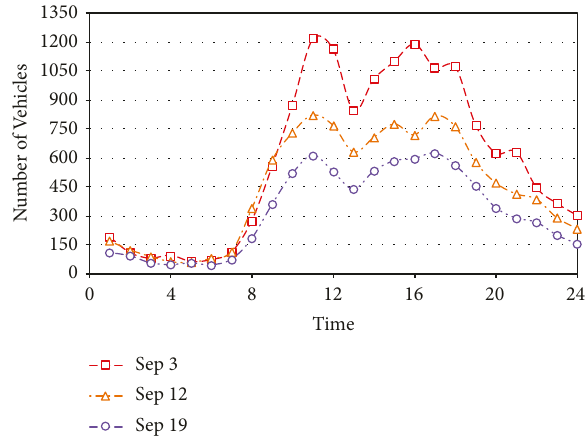
Figure 6: Time-sharing statistics of traffic